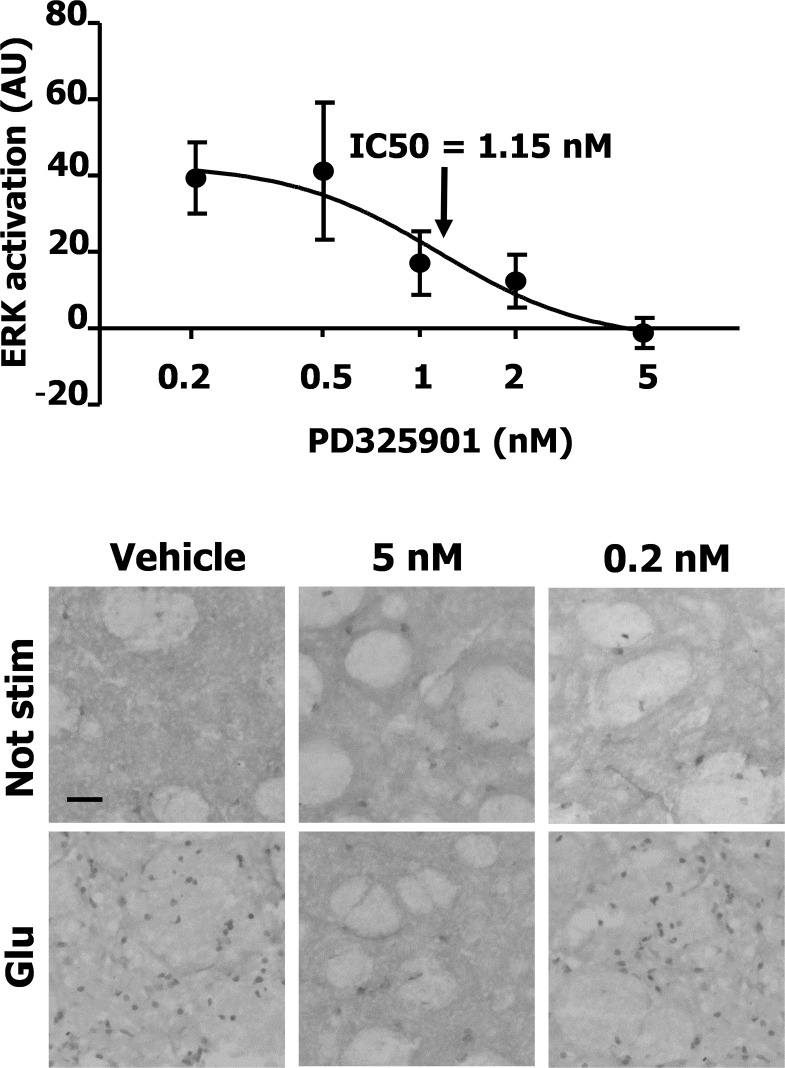
PD325901 inhibits ERK phosphorylation in an ex-vivo model of acute striatal slices in a dose-dependent manner.200 μm thick striatal slices obtained from 2-month old mice were transferred into a perfusion chamber for 1 hr at 32°C in the presence of different doses of PD325901 or vehicle. After 1 hr, one group of slices for each condition was fixed in PFA 4% for 15 min, while another group was stimulated with glutamate 100 μM for 10 min prior to fixation. 18 μm cryo-sections were processed for immunohistochemistry with anti-phospho p44/p42 MAP kinase (Thr202/Tyr204). ERK activation is determined by counting the number of phospho-ERK positive neurons in each slice. The level of activation is expressed on the Y-axis as arbitrary units (AU). Doses are reported in logarithmic scale (Log10) on the X-axis. The IC50was calculated for the specific response using GraphPad Prism software. As shown in the graph, PD325901 is effective in reducing glutamate-induced ERK activation with an IC50 of 1.15 nM. Scale bar 100 µm.